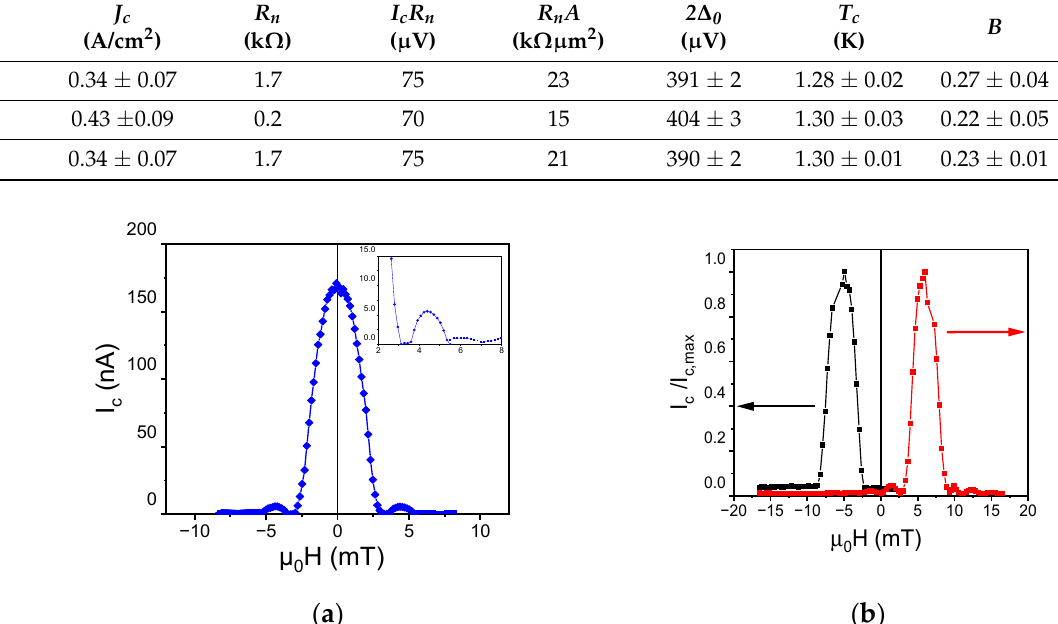
Figure 5. ( a ) Critical current vs. parallel magnetic field measured ( I c ( H ) curve) measured at T = 10 mK for the SIS’FS junction with a diameter of 10 μ m, showing the familiar Airy diffraction pattern. In the inset, a magnification of the two first secondary lobes is shown. ( b ) Hysteretic behavior of the I c /I c,max vs. H curve acquired applying a magnetic field larger than 30 mT. The black and the red curves are the magnetic pattern in the downward and upward direction of the magnetic field, re- spectively.